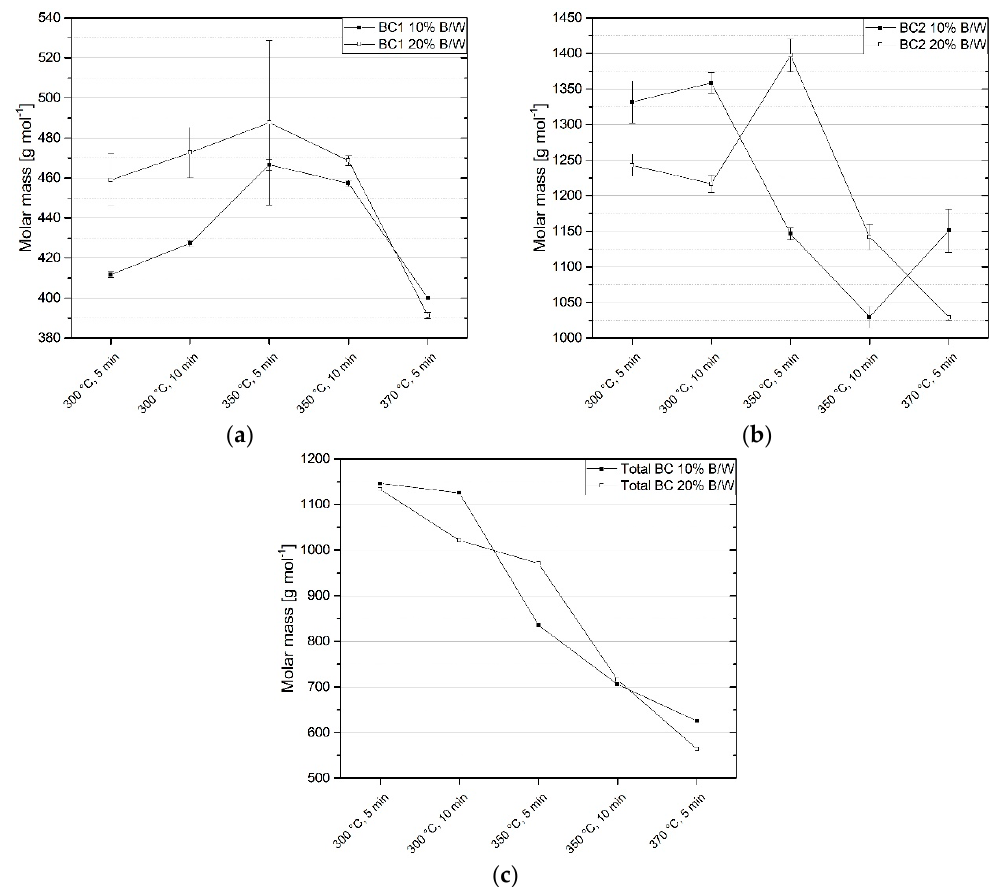
Figure 13. Weight-average molecular weight at different reaction conditions: ( a ) biocrude 1, ( b ) biocrude 2, ( c ) total biocrude. Error bars represent the absolute standard deviation.